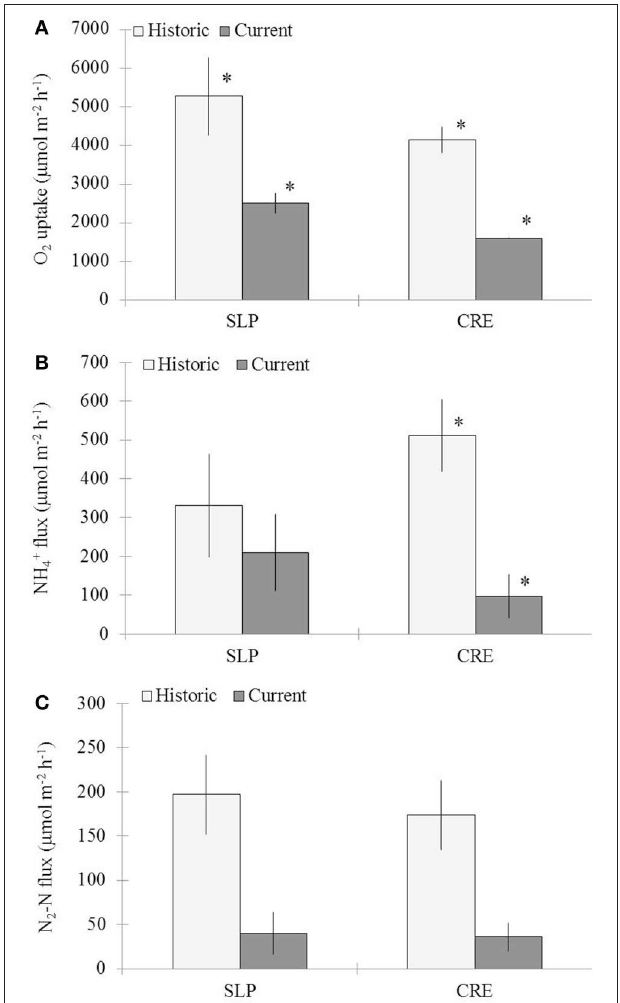
FIGURE 4 | Comparison of historic (July–October, 1992–1994) (LaMontagne, 1996) and current (July–October, 2011–2012) benthic flux rates of (A) oxygen (O 2 ), (B) ammonium (NH + 4 ), and (C) di-nitrogen gas per mole nitrogen (N 2 -N) for direct measurements made from sealed cores collected from Sage Lot Pond (SLP) and Childs River Estuary (CRE) in Waquoit Bay. Bars represent station means ( ± standard error) from incubation dates (SLP Historic n = 4 , SLP Current n = 3 except for N 2 -N flux n = 2 , CRE Historic n = 10 except for NH + 4 n = 9 , CRE Current n = 3 ). For the comparison between historic and current means for each station stars above the bars indicate fluxes that are significantly different from each other ( α =